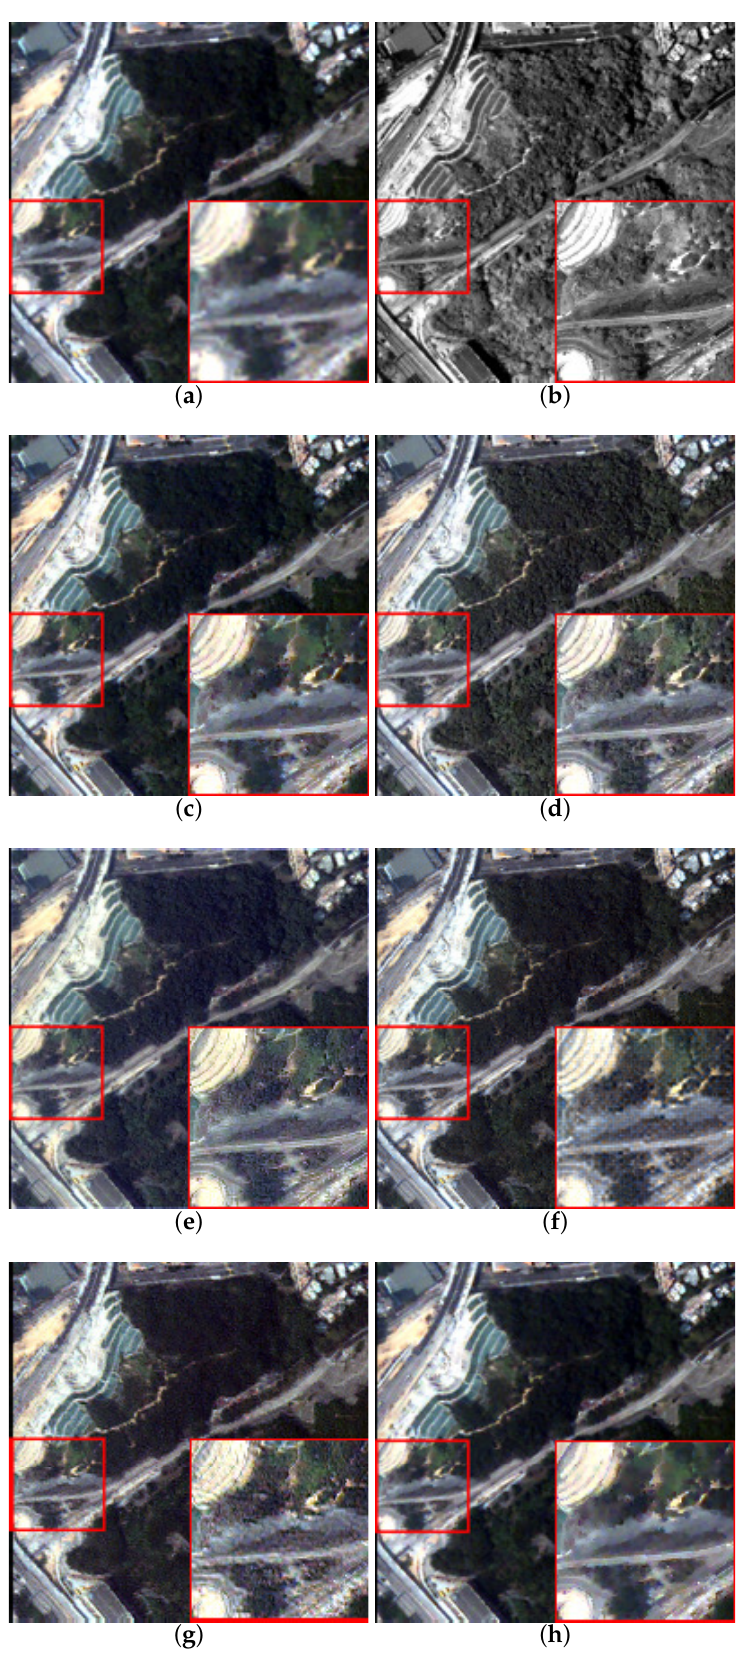
Figure 5. Fusion results of six different PS fusion methods in QuickBird data fusion. ( a ) Upsampled MS. ( b ) PAN. ( c ) IAIHS. ( d ) GSA. ( e ) HPF. ( f ) RR. ( g ) A-PNN. ( h )